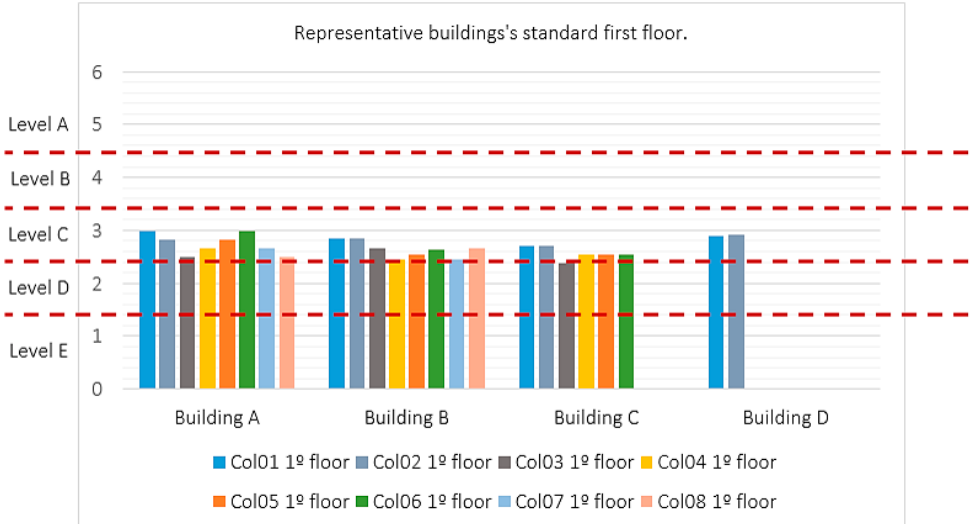
Figure 7. Final classification of the housing unit HU (standard first floor) with the water heating system.